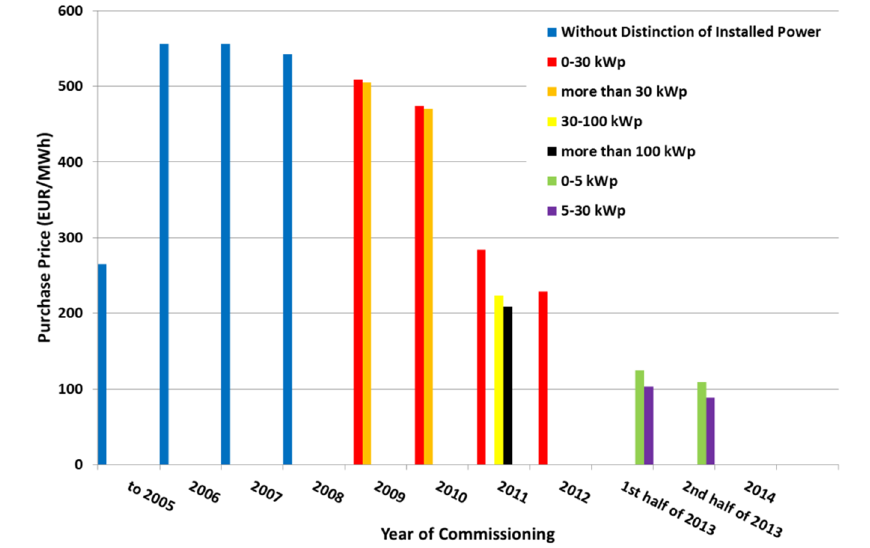
Figure 2. Development of purchase prices between the years 2005 and 2014 in CR